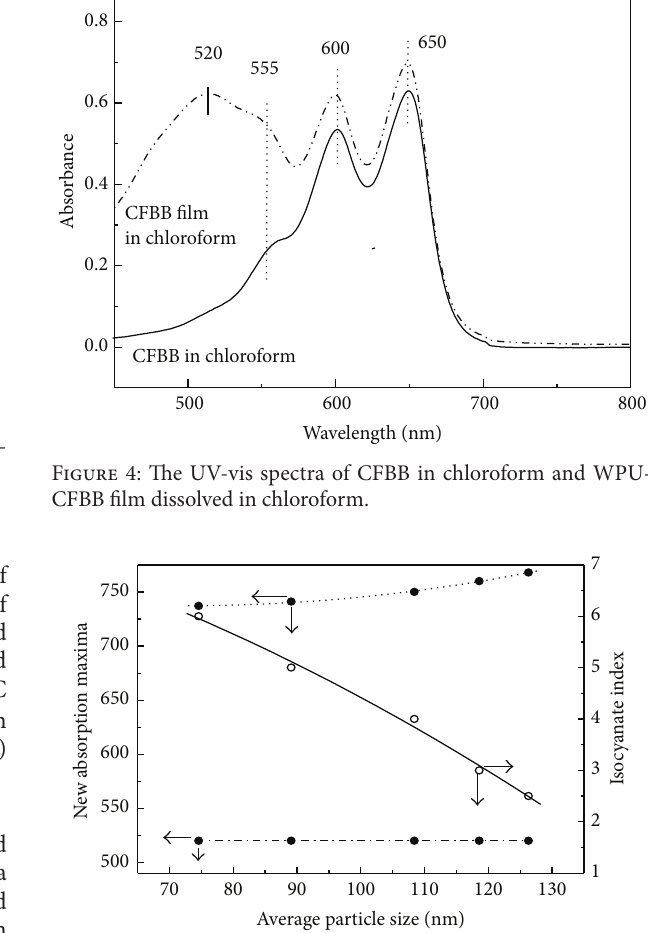
Figure 5: Relationships between the isocyanate index, the average particle size, and the two new absorption maxima for WPU-CFBB